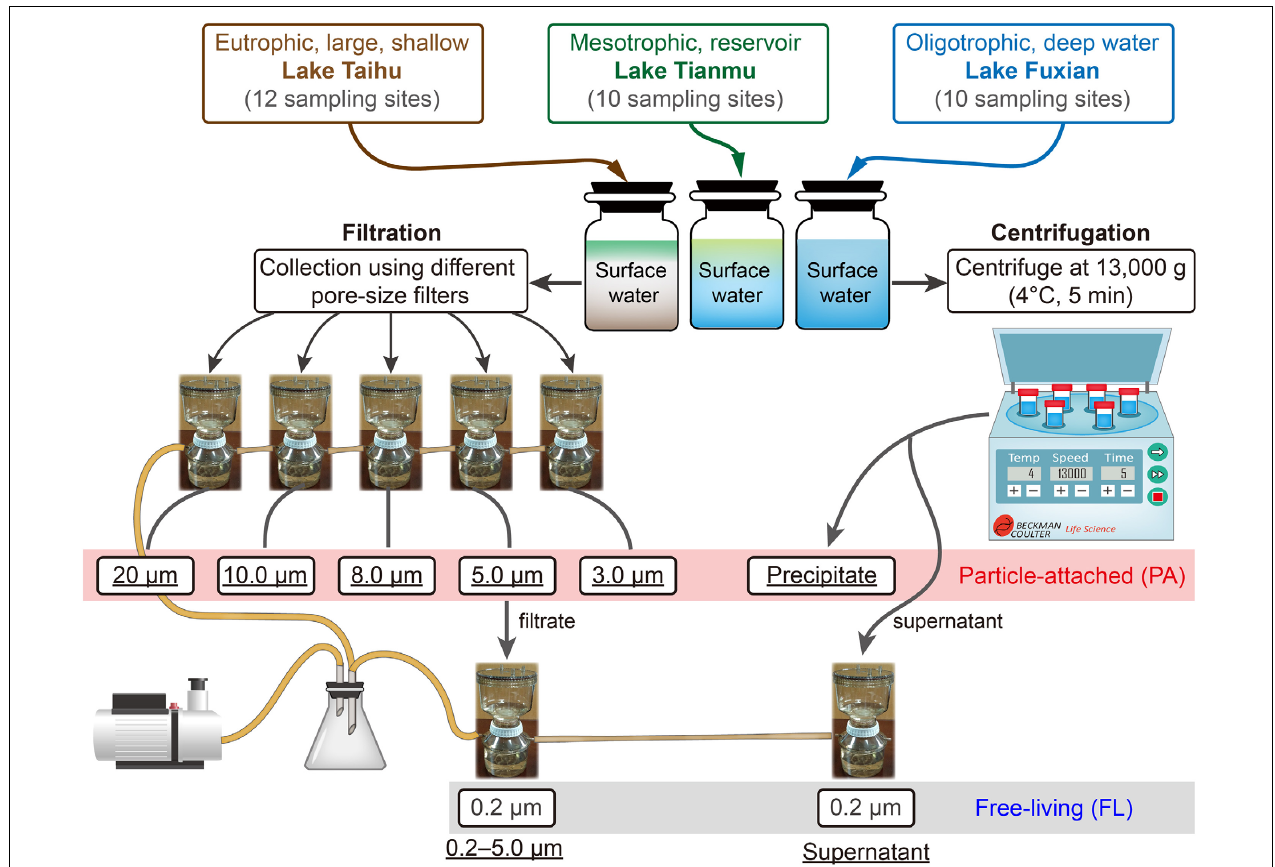
FIGURE 2 | The schematic diagram of experiment design, and the different treatments for collecting particle-attached (PA, six treatments in the red box) from Lake Taihu, Lake Tianmu, and Lake Fuxian. The < 5.0 µ m-filtrate and the supernatant after centrifugation are subsequently filtrated by 0.2 µ m filter membranes and are considered as free-living (FL, in the gray box) bacterial samples. The terms underlined represent the designated names of the treatments.